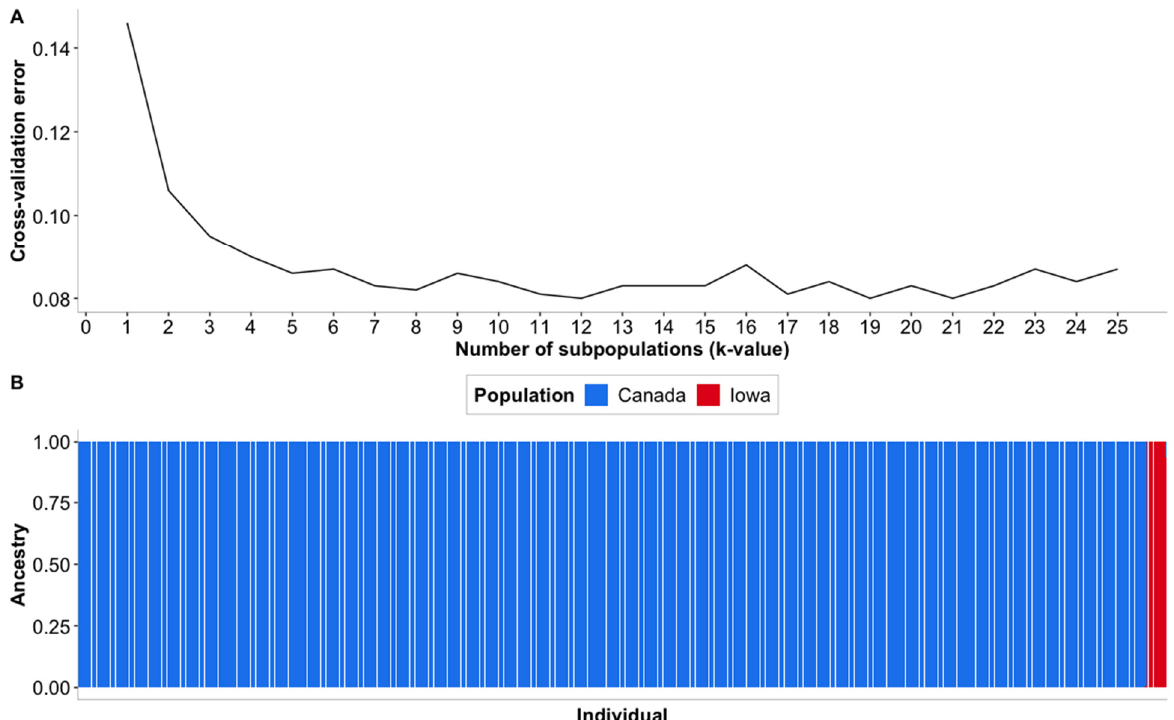
Figure 5. ( A ). Cross-validation error value for multiple subpopulation numbers. ( B ). Admixture plot for two subpopulations.